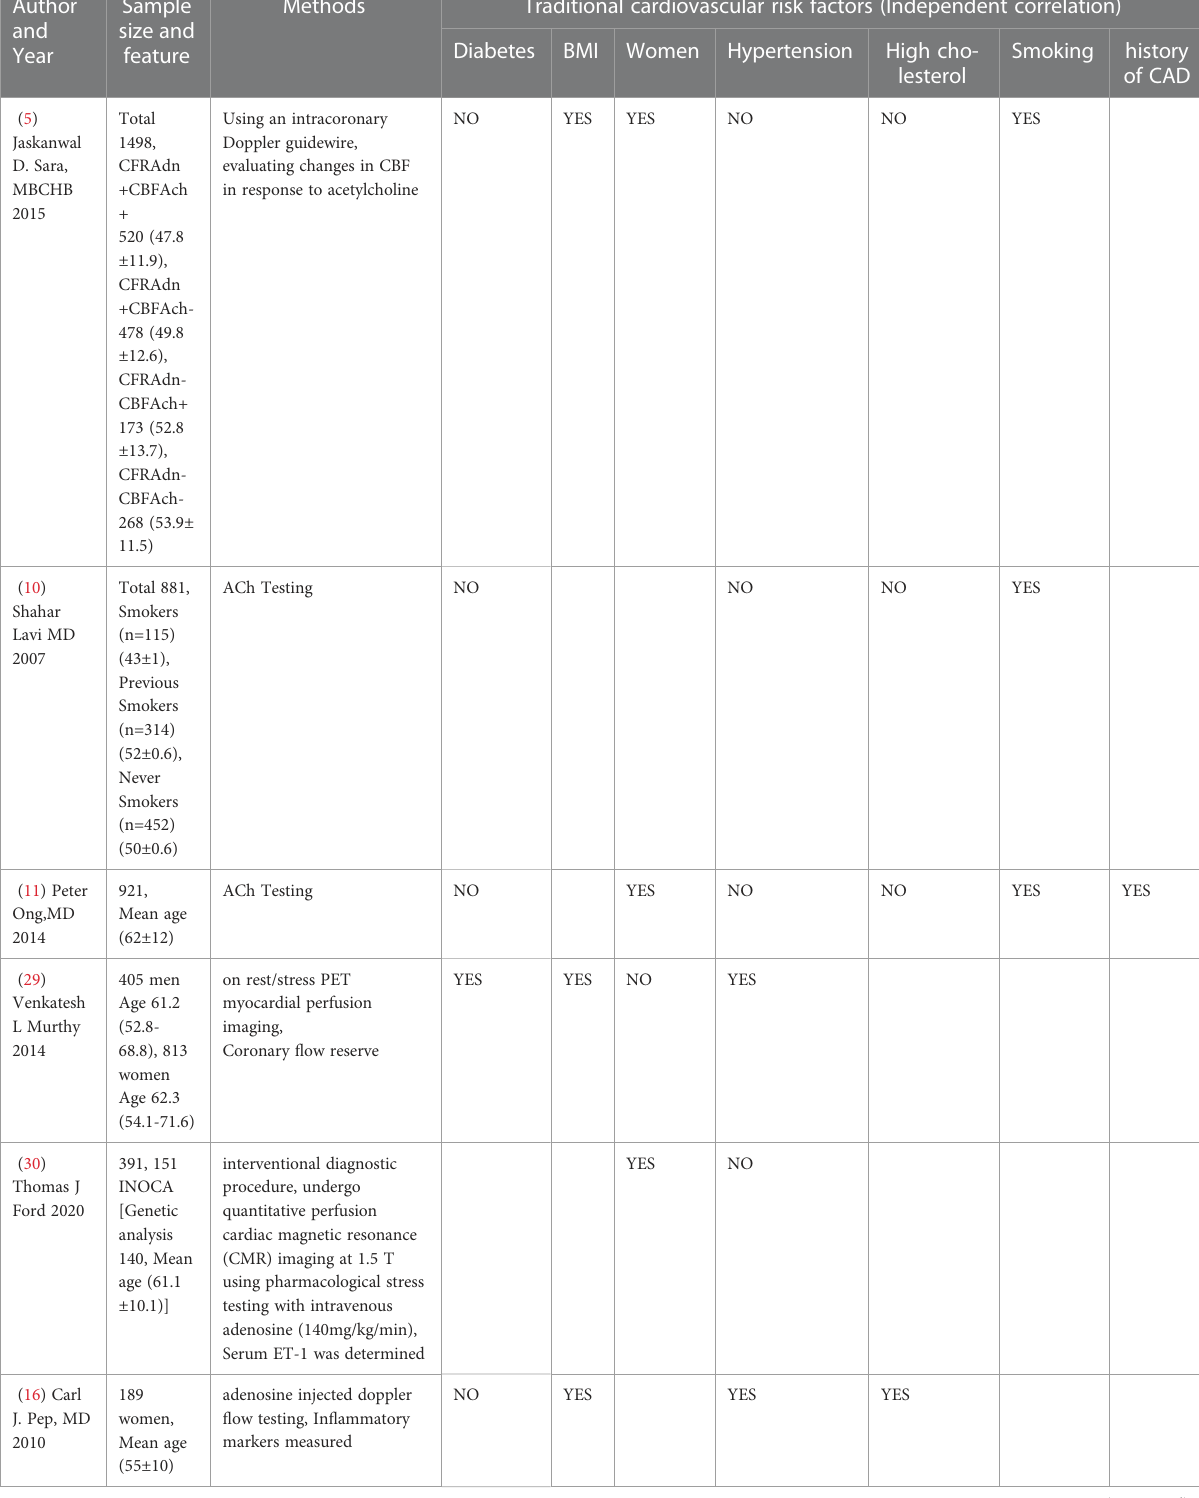
TABLE 2 Independent association of INOCA with traditional cardiovascular risk